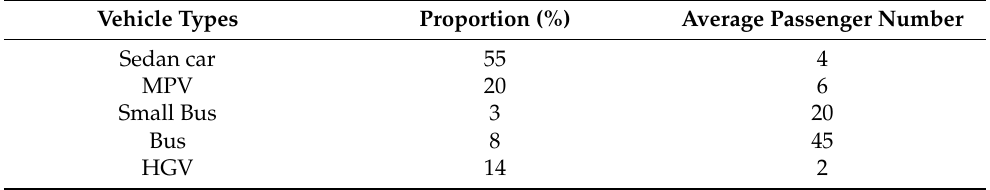
Table 6. Traffic composition of tunnel.